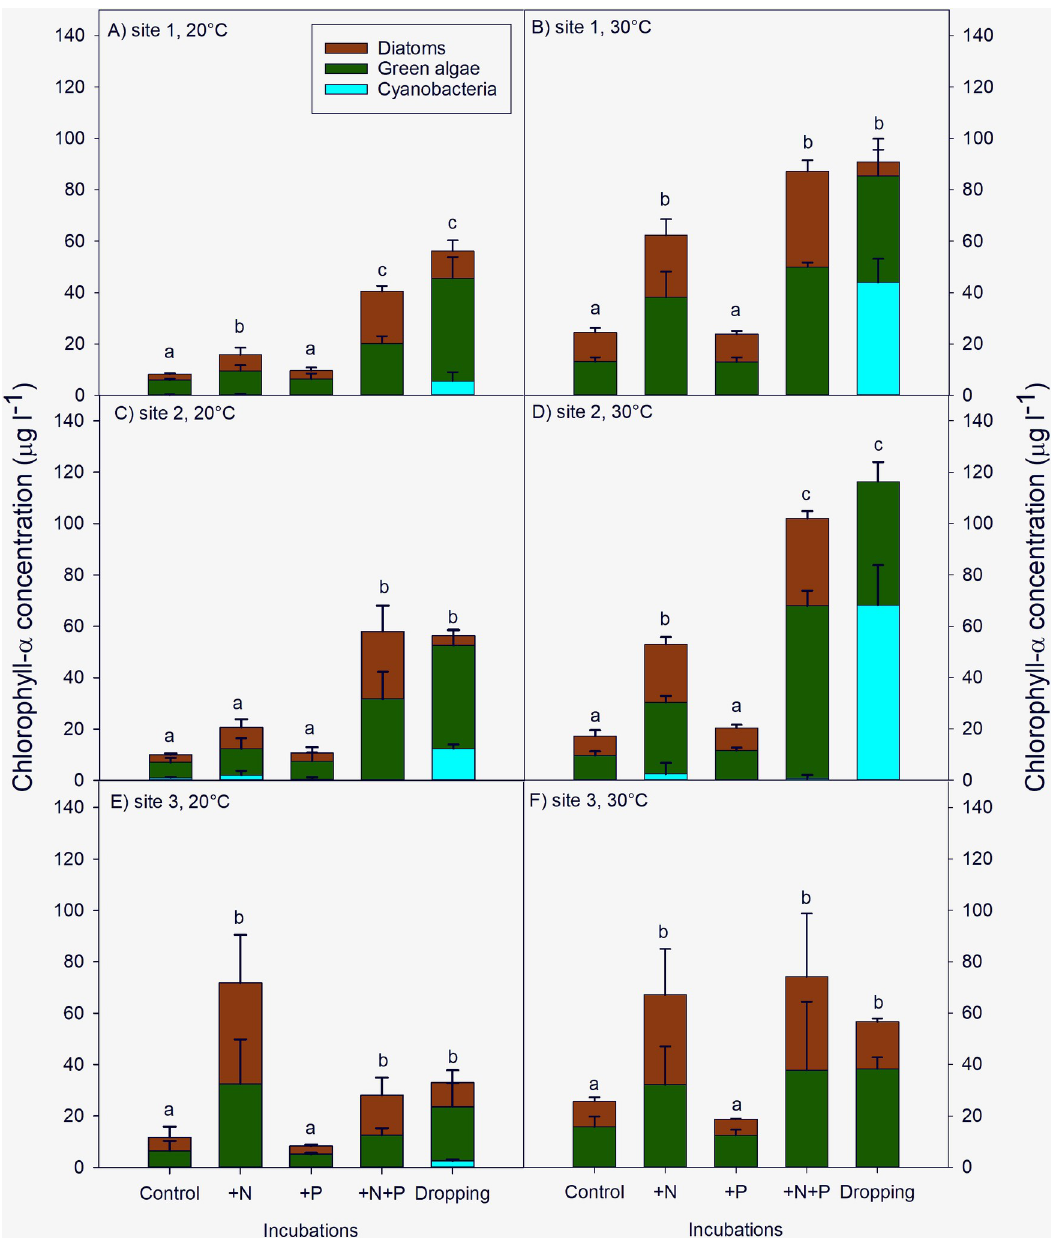
Fig 3. Cyanobacterial (blue), green algae (green), and diatoms (brown) chlorophyll-a. Concentrations as measured with PHYTO-PAM ( μ g L -1 , mean ± standard deviation) at surface water sampled from three locations (Site 1,2,3) in Lake Lesser Prespa. The water had been incubated for seven days at 20˚C and 30˚C, without extra nutrients added (Control), with solely N-added (+N), solely P-added (+P), both N+P added (+N+P) and pelican droppings added (Dropping). Error bars indicate the standard deviation (n = 3). Similar letters above the bars indicate homogeneous groups per panel (total chlorophyll-a) that are not different at the 95% level. (F = 4.1; p = 0.014;). At both temperatures, +N+P and Dropping treatment were not signifi- 4,29 cantly different, while control and +P treatments were not significantly different from each other either. The +N treatment had a significantly higher chlorophyll-a concentration than